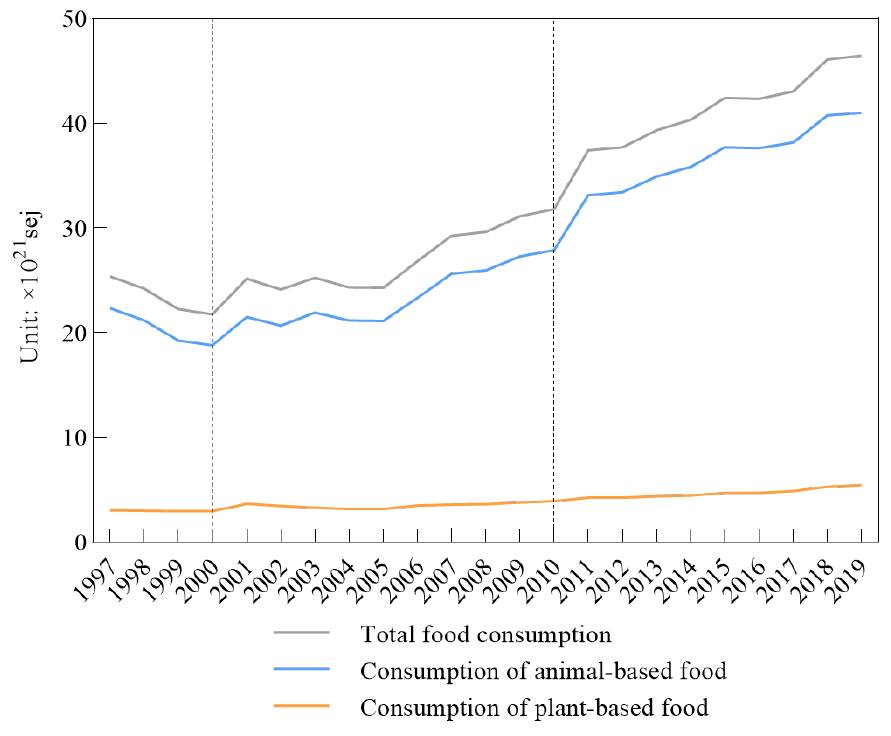
Figure 2. Annual food consumption in Kazakhstan.